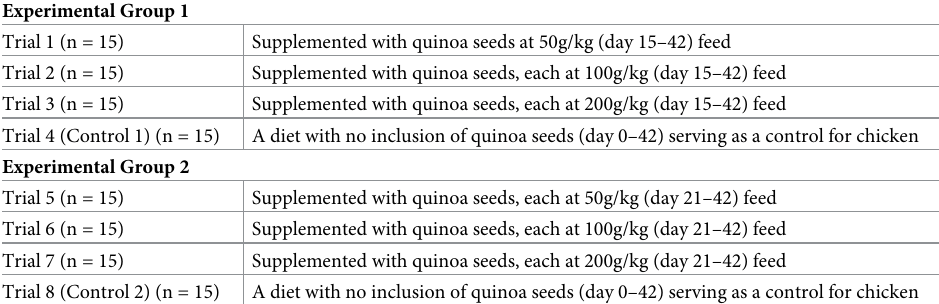
Table 2. Different study groups were used for the examination of quinoa supplemented